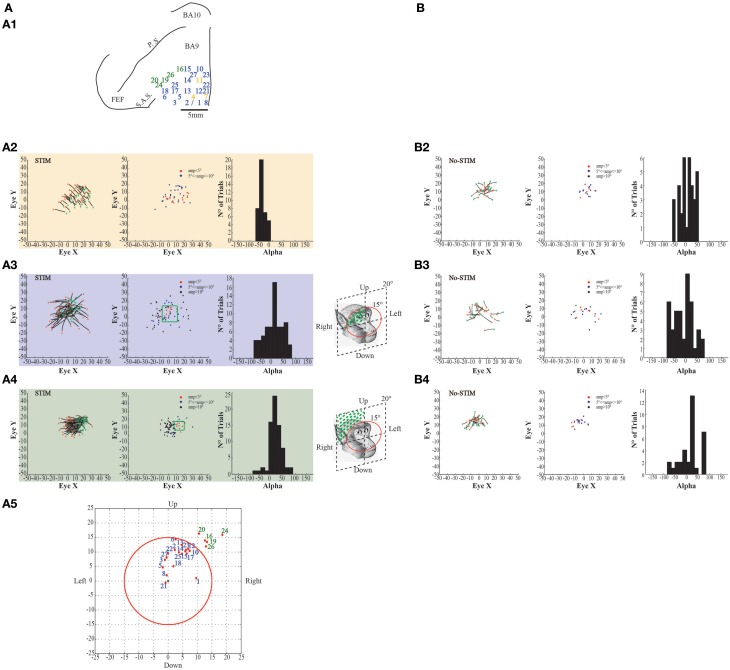
Example of evoked eye movements. (A) The figures show data from Monkey S. For further information on the figures the reader should refer to the legend of Figure 6.